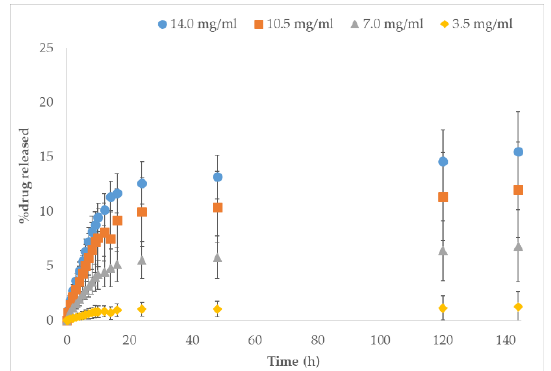
Figure 2. Comparative release profile based of NFC/PVA films over 144 h ( n = 6) in varying